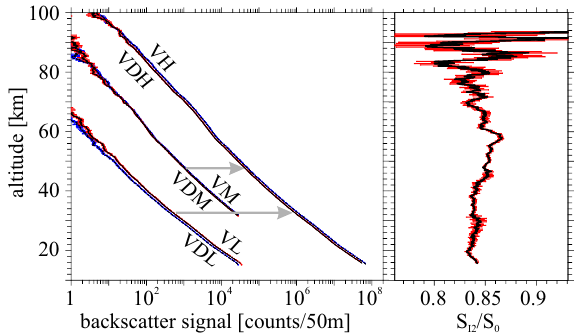
Fig. 6. Left: Backscatter profile of the vertical pointing telescope on 17 January 2009 from 17:00 to 19:00UT. Data of the chan- nel groups “VDH, VDM, VDL” (black/blue) and “VH, VM, VL” (black/red) is combined to two profiles S I and S 0 , respectively. The 2 measurement uncertainty (1 σ ) is indicated by red or blue horizon- tal bars. Grey arrows indicate the altitude where the channels were /S 0 and the cor- combined. Right: Measured Doppler ratio D = S I 2 responding error bars